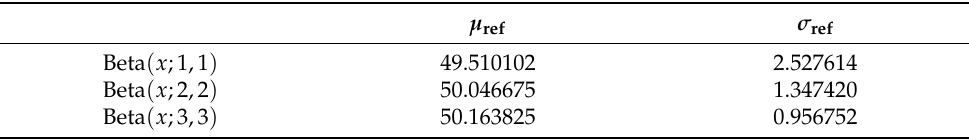
Table 1. The reference values of µ and σ . Computed with MC using LHS and 10 6